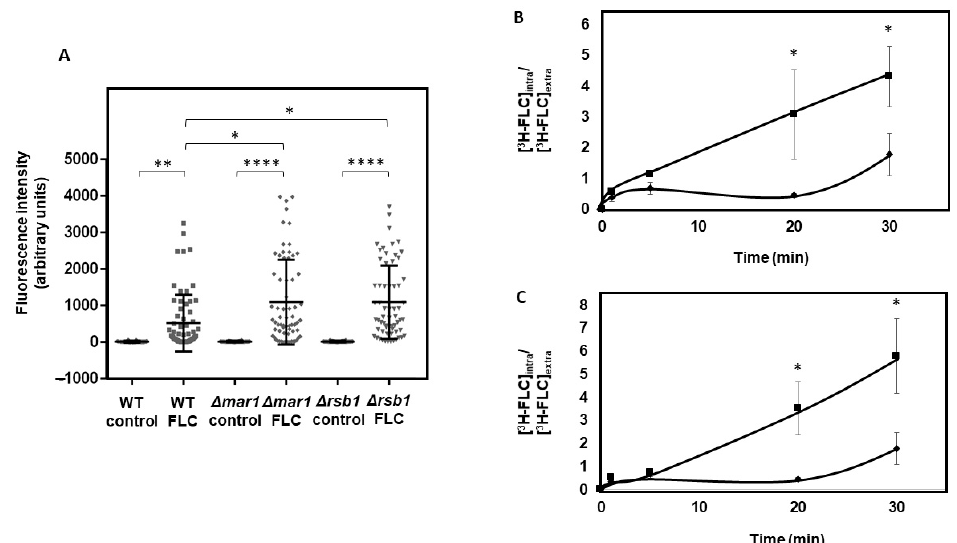
Figure 4. CgMar1 and its activated target CgRsb1 control permeability and drug accumulation in C . glabrata cells during fluconazole stress. ( A ) Comparison of cell permeability of the KUE100 C . glabrata wild-type (squares) and derived KUE100_ Δ cgmar1 (diamonds) and KUE100_ Δ cgrsb1 (triangles) deletion mutant cells under control conditions or after 1 h of fluconazole exposure. The estimation of cell permeability is based on the fluorescence intensity values exhibited by yeast cells upon the passive accumulation of propidium iodide. Error bars represent the corresponding standard deviations. ( B ) Time course accumulation of radiolabeled [ 3 H]fluconazole in KUE100 C . glabrata wild-type (diamonds) and derived KUE100_ Δ cgmar1 (squares) deletion mutant cells during cultivation in the presence of unlabeled fluconazole. ( C ) Time course accumulation of radiolabeled [ 3 H]fluconazole in KUE100 C . glabrata wild-type (diamonds) and derived KUE100_ Δ cgrsb1 (squares) deletion mutant cells during cultivation in the presence of unlabeled fluconazole. Accumulation values are the averages of at least three independent experiments. Error bars represent the corresponding standard deviations. * p -value < 0.05, ** p -value < 0.01, and **** p -value < 0.0001.